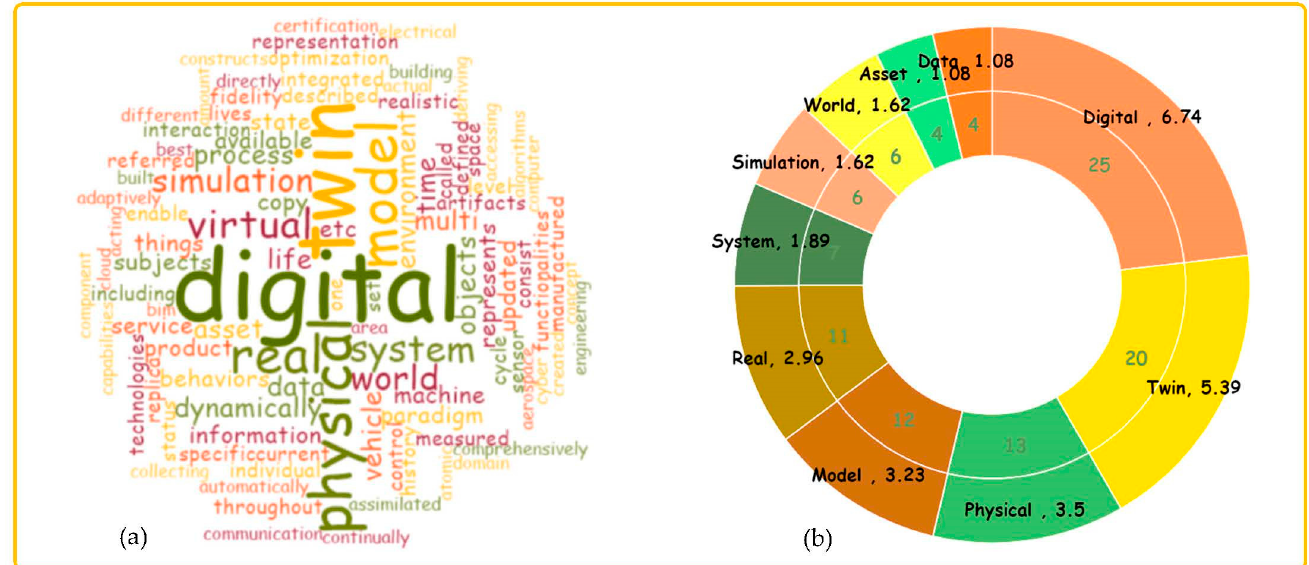
Figure 7. The analysis of 21 key definitions of DT published between 2012 and 2019. ( a ) Visualisation of the word frequency; ( b ) the count value for high-frequency words and the weighted percentage among all the stemmed words used in definitions.